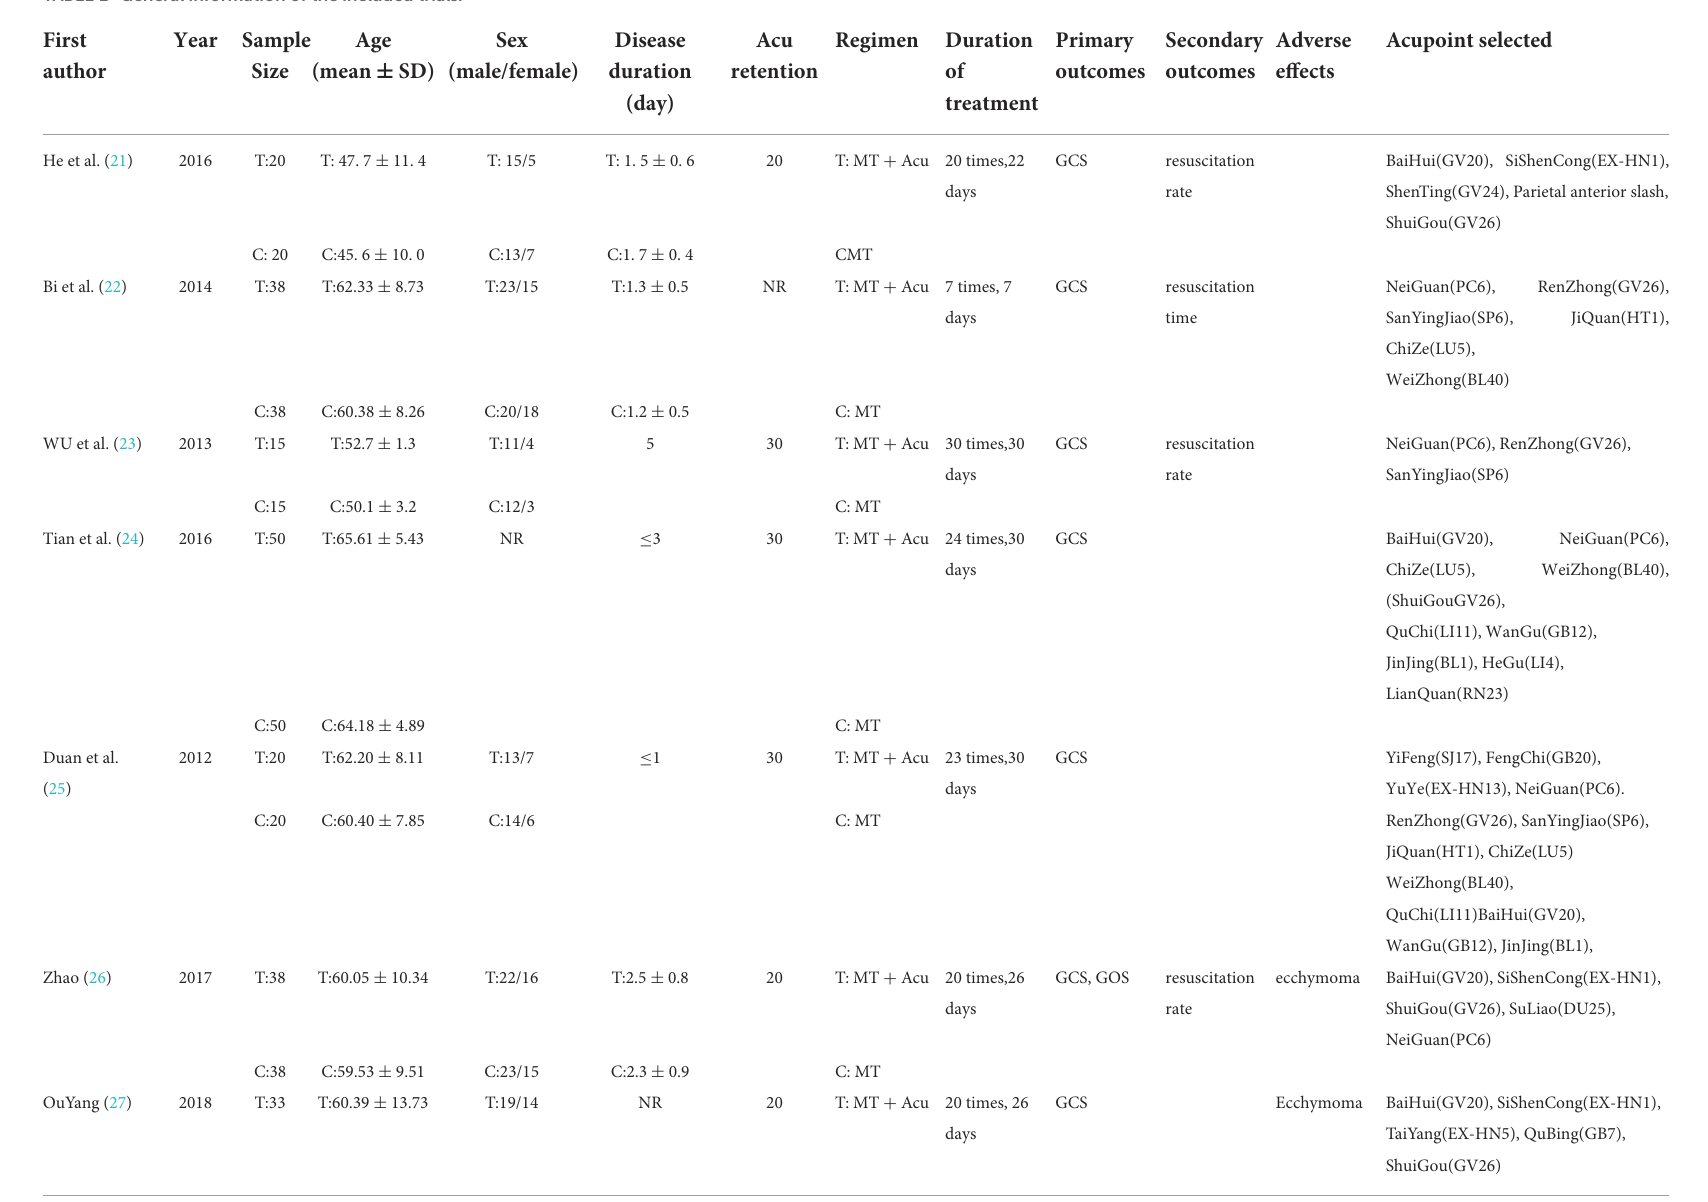
TABLE 1 General information of the included